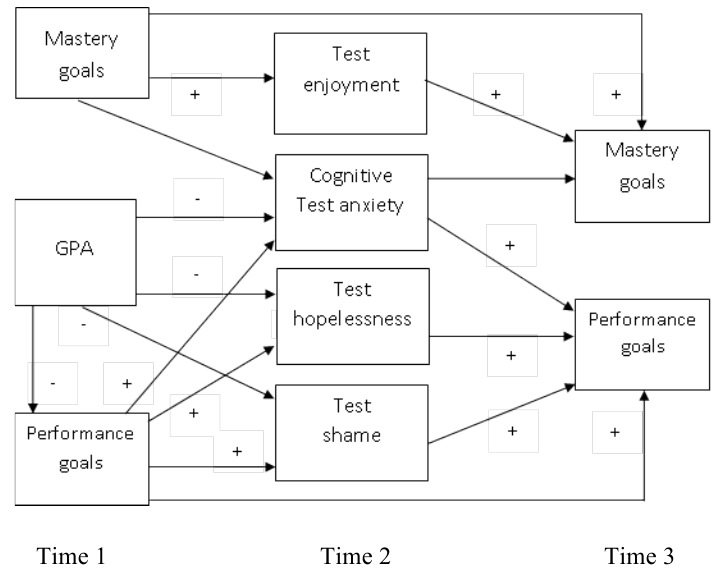
Figure 1 . Hypothesized model depicting the relationships between achievement goals and